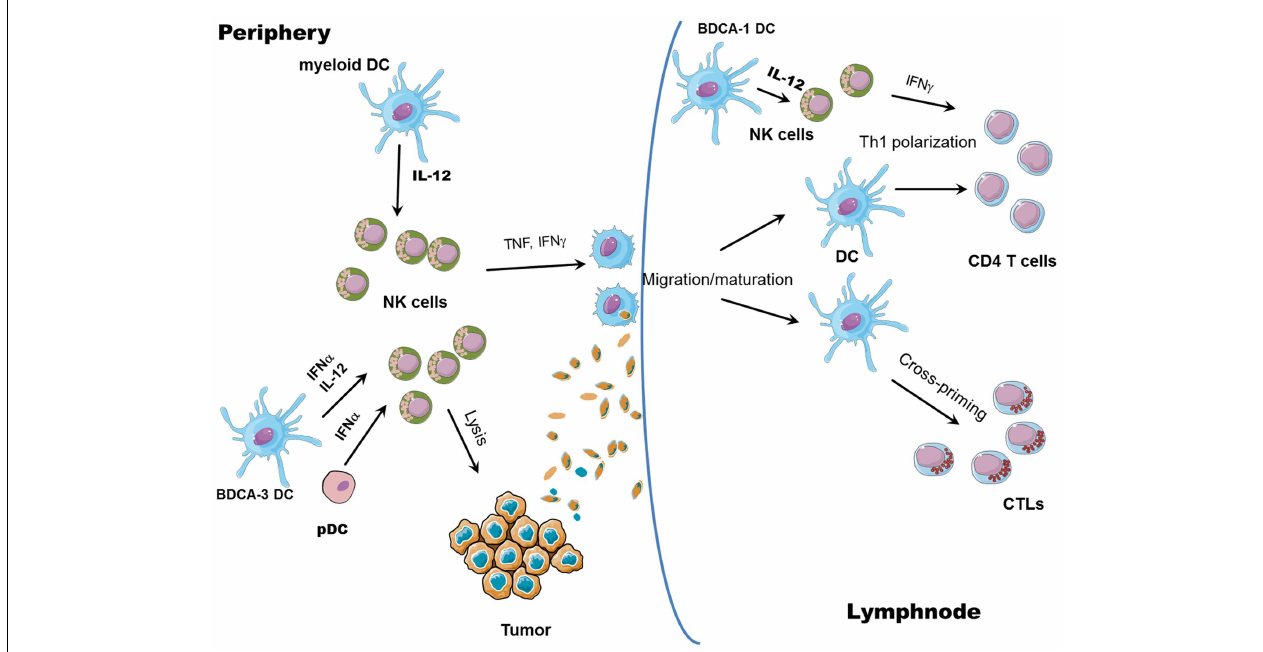
withTNF, DC maturation, and migration to draining lymph nodes. Activated NK cells can also lyse tumor cells, leading to the generation of tumor antigenic material; tumor debris are then engulfed by DCs and tumor antigens are processed and presented by mature DCs to both CD8 + (cross-priming) and CD4 + T